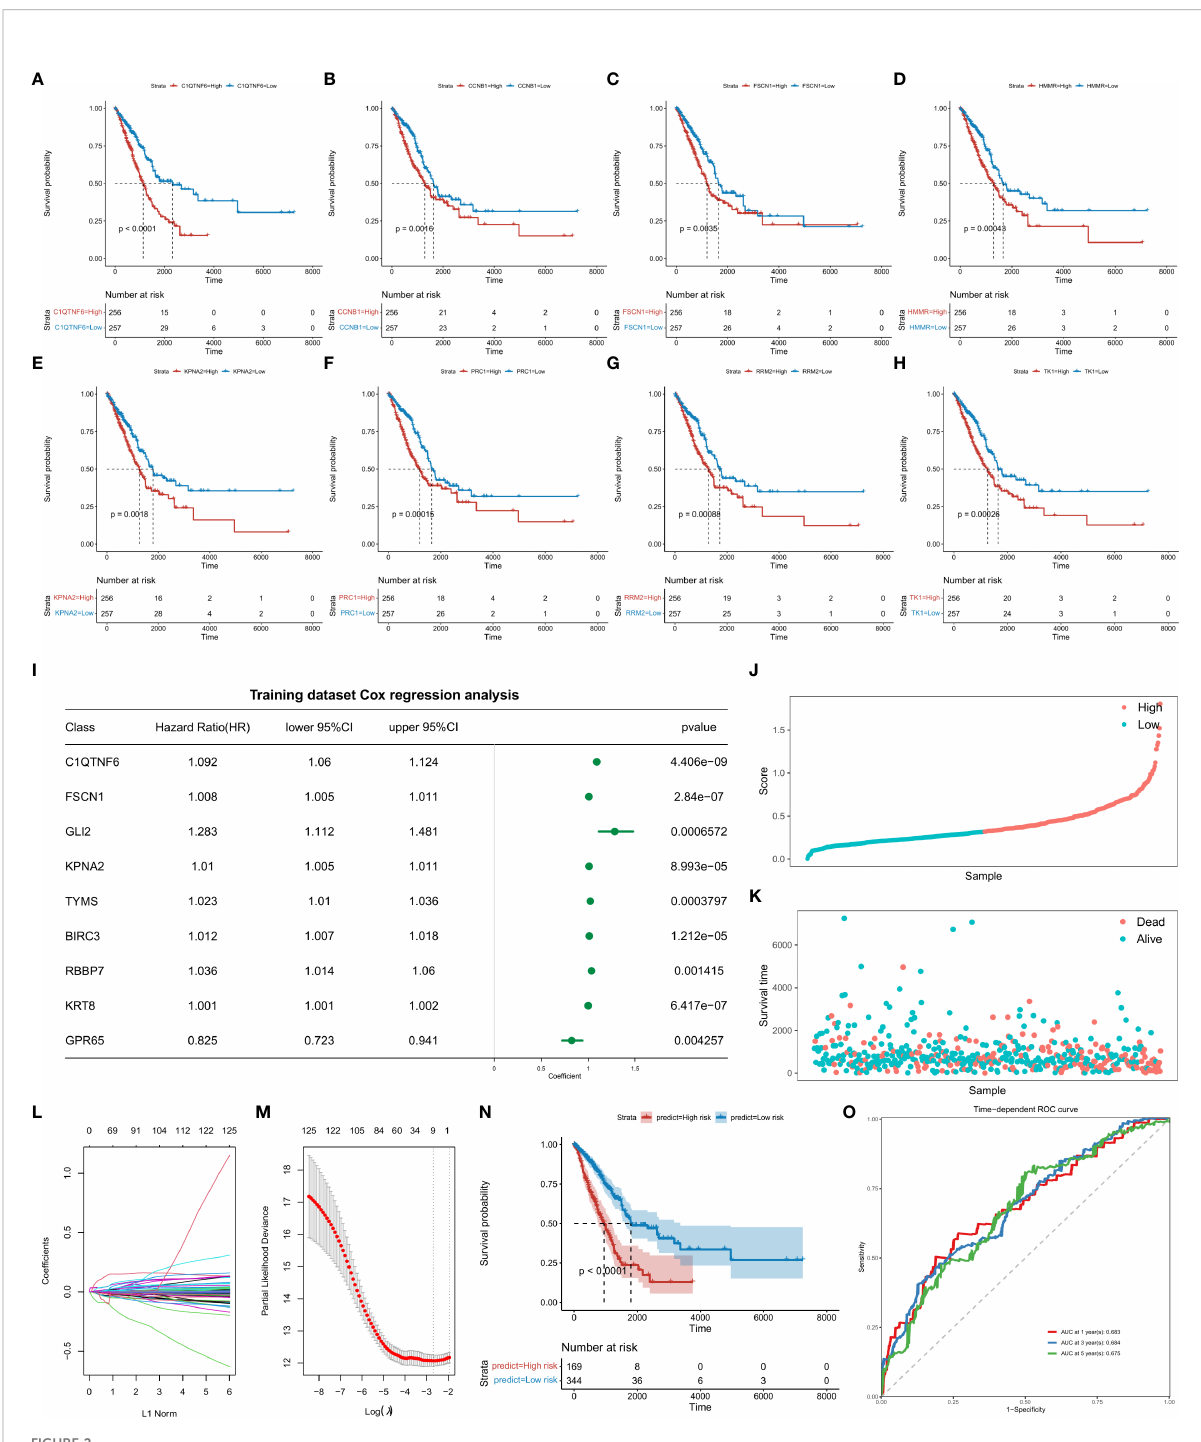
FIGURE 2 Survival analysis of top8 genes is signi fi cantly associated with prognosis. Abscissa axis: survival time. Ordinate axis: survival probability. Colors: differential gene expression. Survival analysis of (A) C1QTNF6, (B) CCNB1, (C) , FSCN1, (D) HMMR, (E) KPNA2, (F) PRC1, (H) RRM2, and (I) TK1. (J) Construction of the risk score model and evaluation of its prognostic ef fi cacy. Forest plots of genes included in the risk score model. Right column: 9 genes included in the risk score model. Left column: corresponding forest plot. (K) Risk score plot for cancer samples (line graph). (L) Risk score plot for cancer samples (scatter plot graph). (M) Dynamic process diagram of variables screened by LASSO regression analysis and selection process diagram of the cross-validation parameter l . (N) Survival analysis of the training dataset. Abscissa axis: survival time; ordinate axis: survival probability. (O) ROC curve of training datasets. Abscissa axis: speci fi city; Ordinate axis: sensitivity. Colors represent different